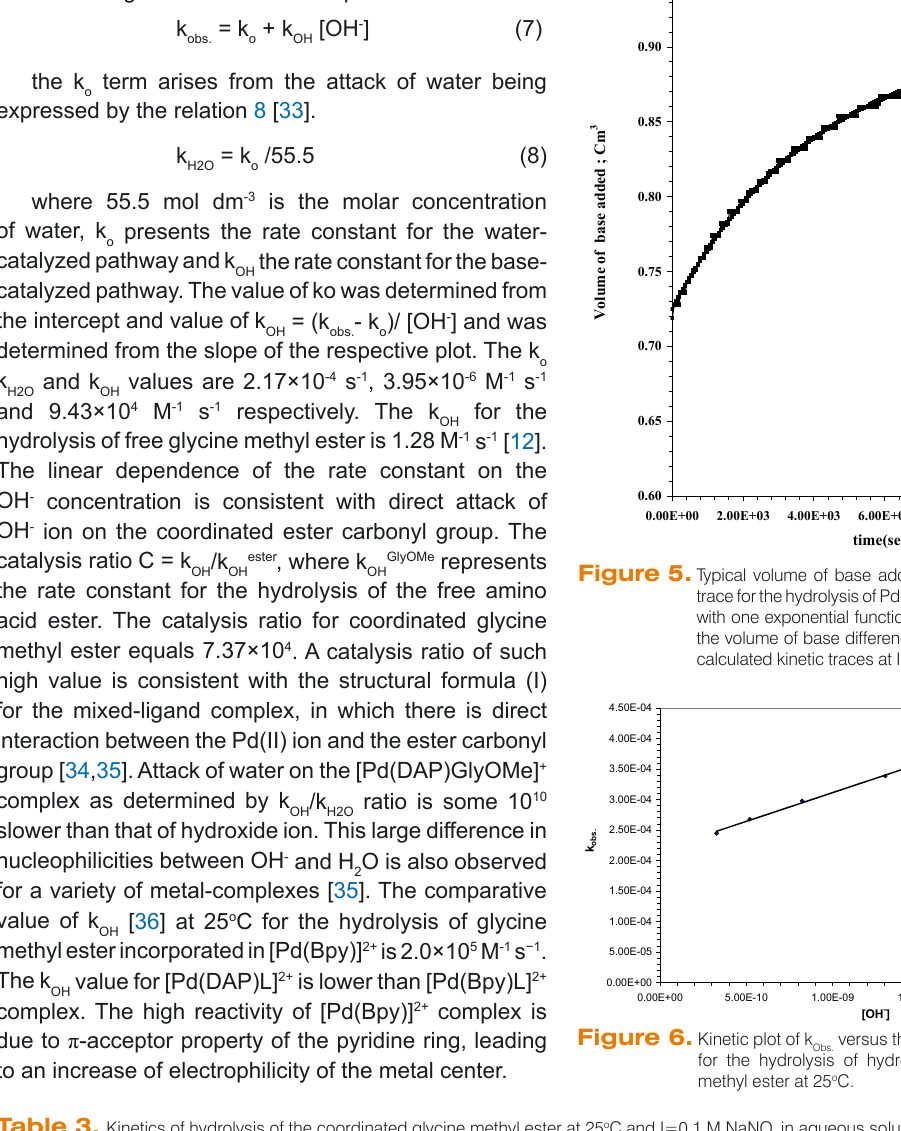
Table 3. Kinetics of hydrolysis of the coordinated glycine methyl ester at 25 o C and I=0.1 M NaNO T 0 C